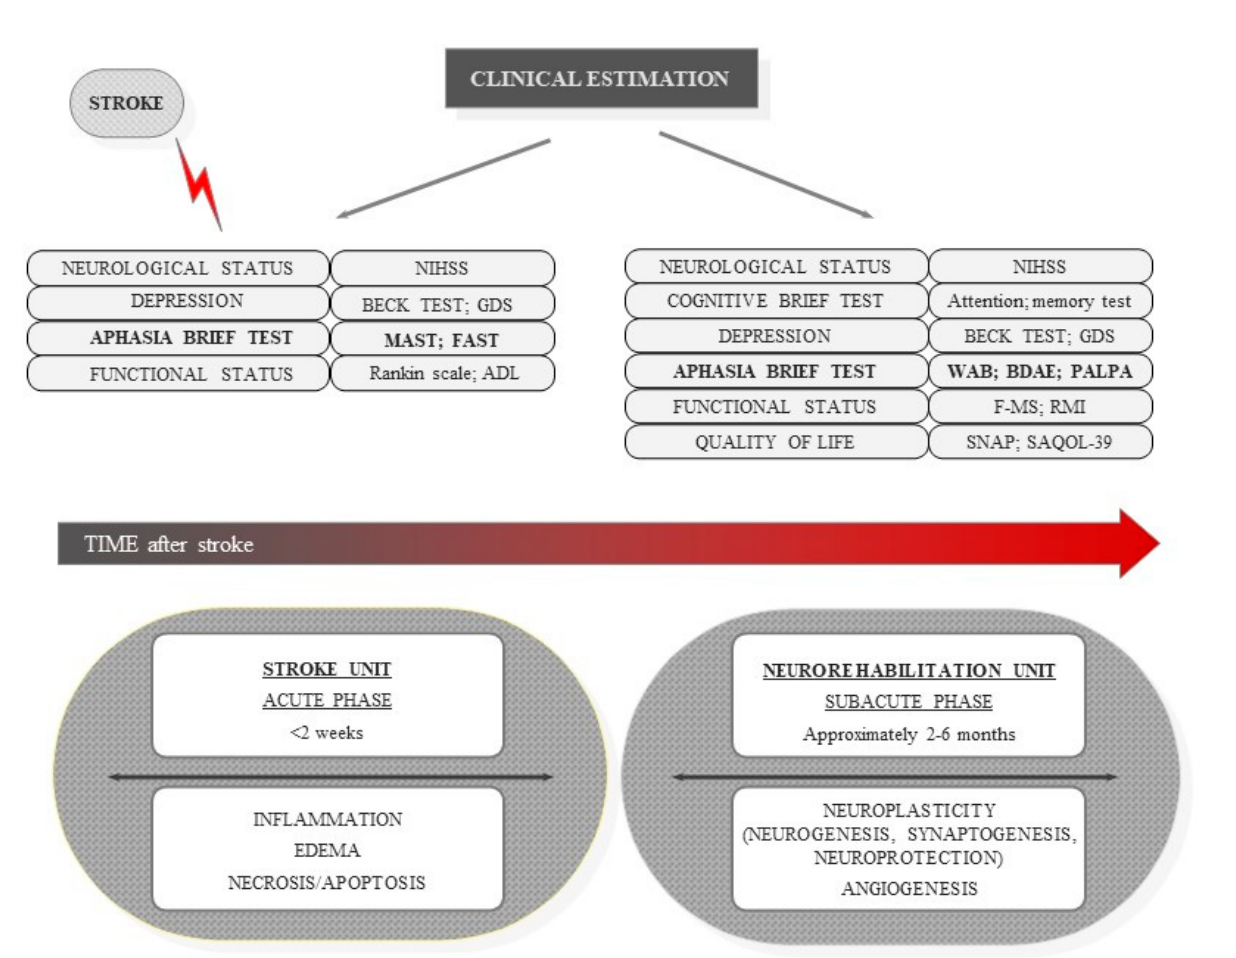
Figure 1. Diagram depicts brain stroke stages with clinical testing tools in different stroke phases evaluation. (NIHSS: National Institutes of Health Stroke Scale, MMSE : mini mental state estimation, GDS : geriatric depression scale, BDI : Beck depression index, MAST : Mississippi Aphasia Screening Test, FAST : Frenchay Aphasia Screening Test, ADL : activity daily living, WAB : Western Aphasia Battery, BDAE : Boston Diagnostic Aphasia Examination, PALPA : Psycholinguistic Assessment of Language Processing in Aphasia, F-MS: Fugl-Meyer Scale, RMIL : Rivermead Mobility Index, SNAP: social network with aphasia profile test, SAQOL-39: aphasia quality of life scale-39).